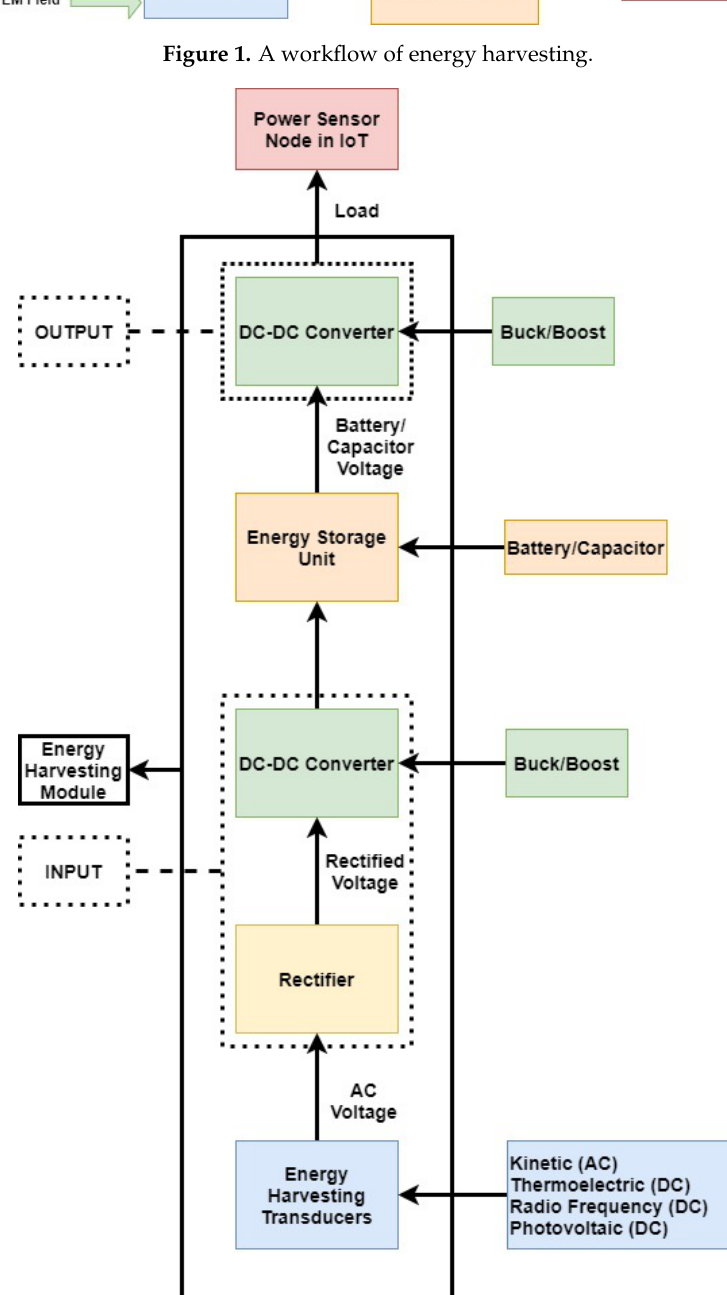
Figure 2. Mechanism for various energy harvesting